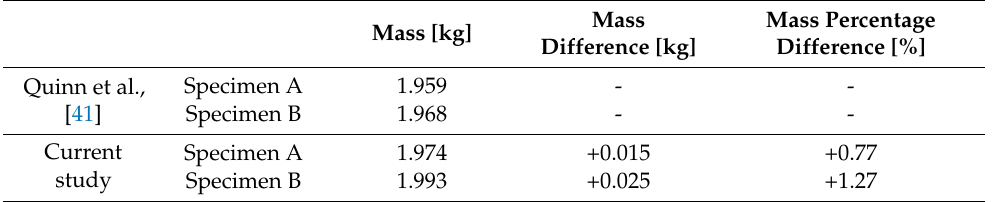
Table 4. Comparative mass of the specimens.